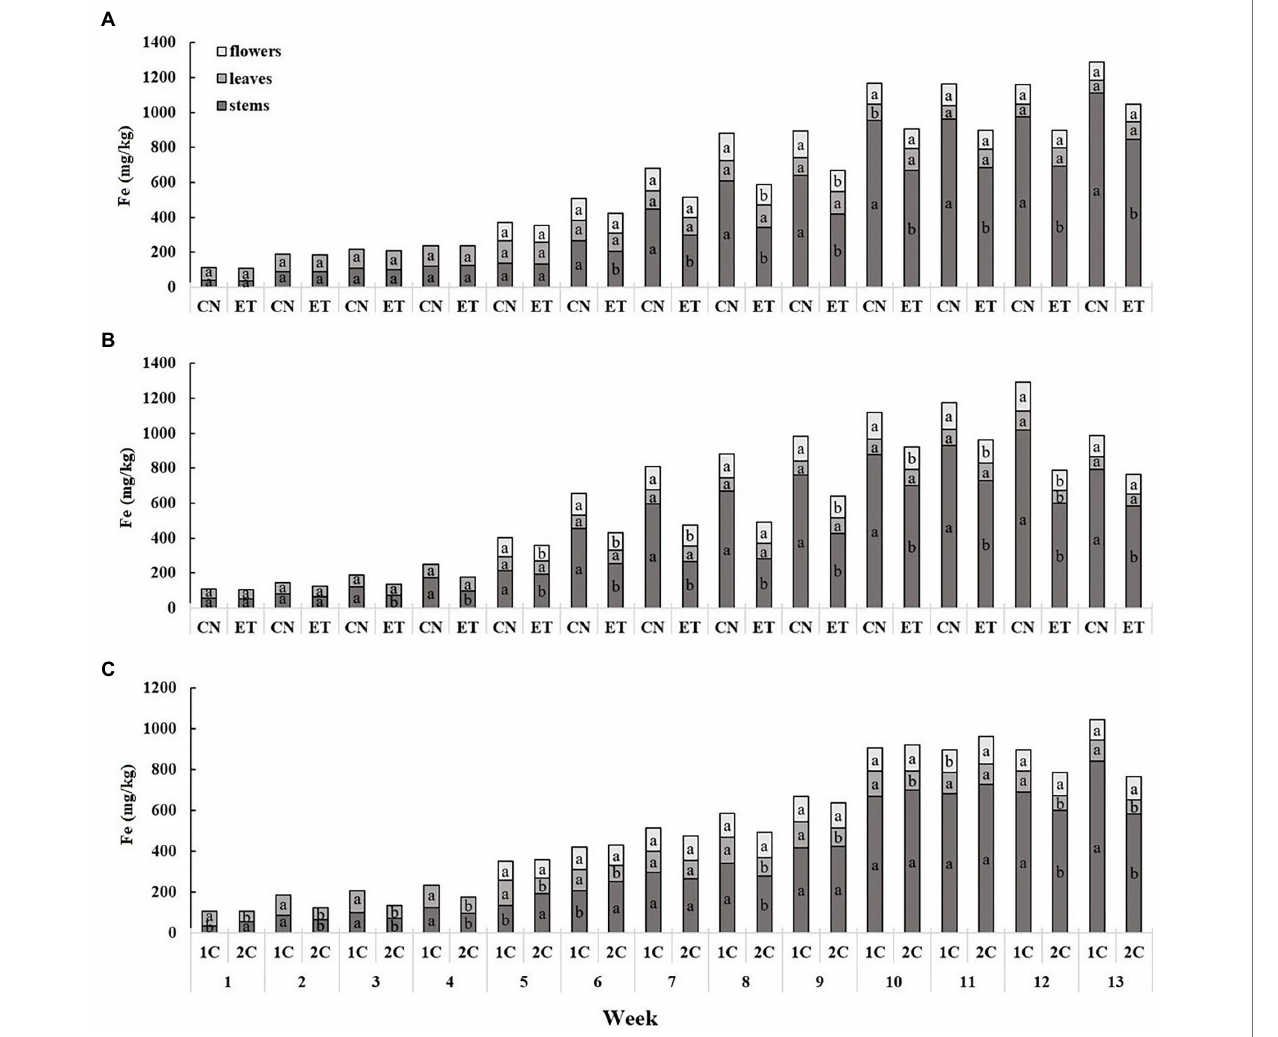
FIGURE 5 | Distribution of iron among the organs of medical cannabis plants as affected by amino acid (AA) supplementation and nutrient cycle. Fe concentration in control (CN) and enhanced treatment (ET) plants with AAs nutritional supplements in recirculation (1C) growing cycle (A) , in drain-to-waste (2C) growing cycle (B) , ETs in 1C and 2C (C) in stems, leaves, and flowers. Data are means ± SE ( n = 3). The different small letters inside the bars represent significant differences within the medical cannabis plant organs (stems, leaves, and flowers) between the variants in a particular week according to Tukey’s HSD test at α =